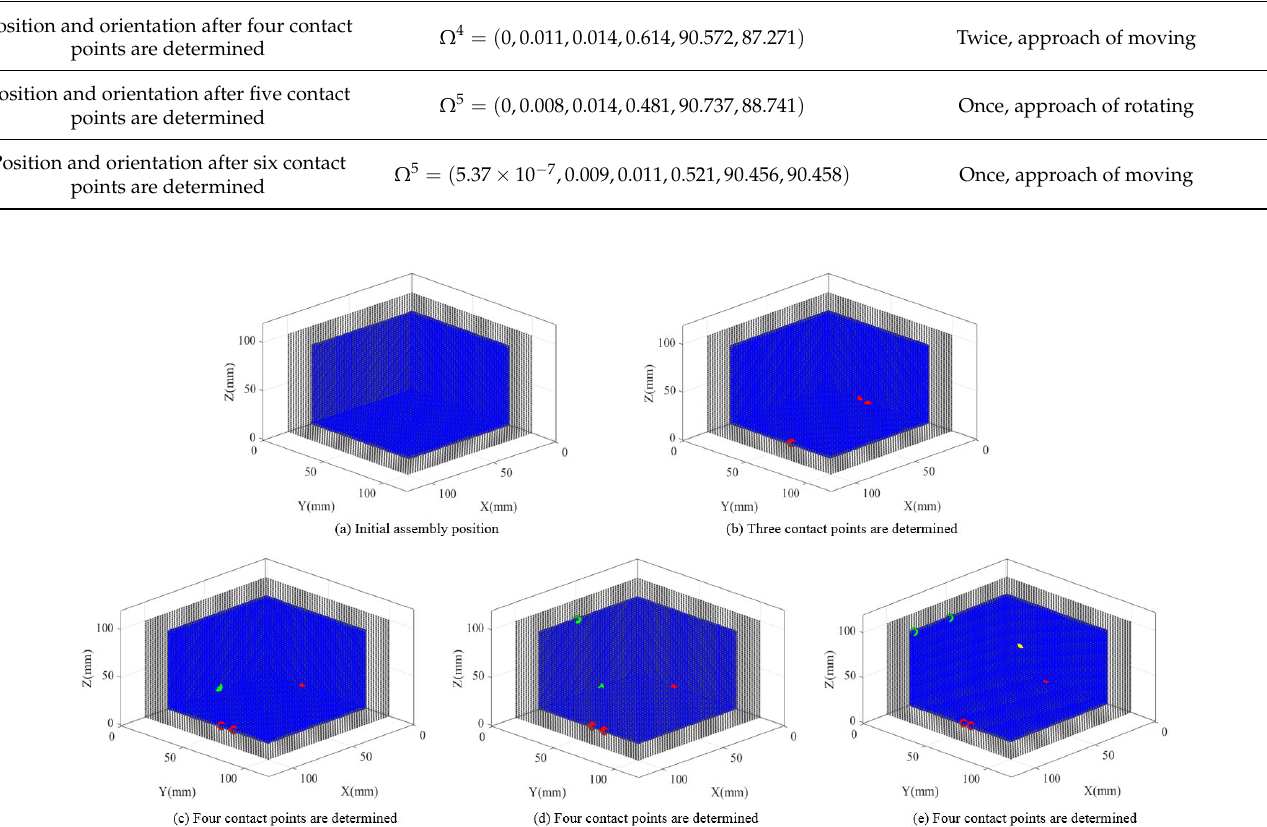
Figure 10. Variations of six contact points. The three contact points on the main mating plane are red, the two contacts point on the first auxiliary mating plane are green, and the contact point on the second auxiliary mating plane is yellow.